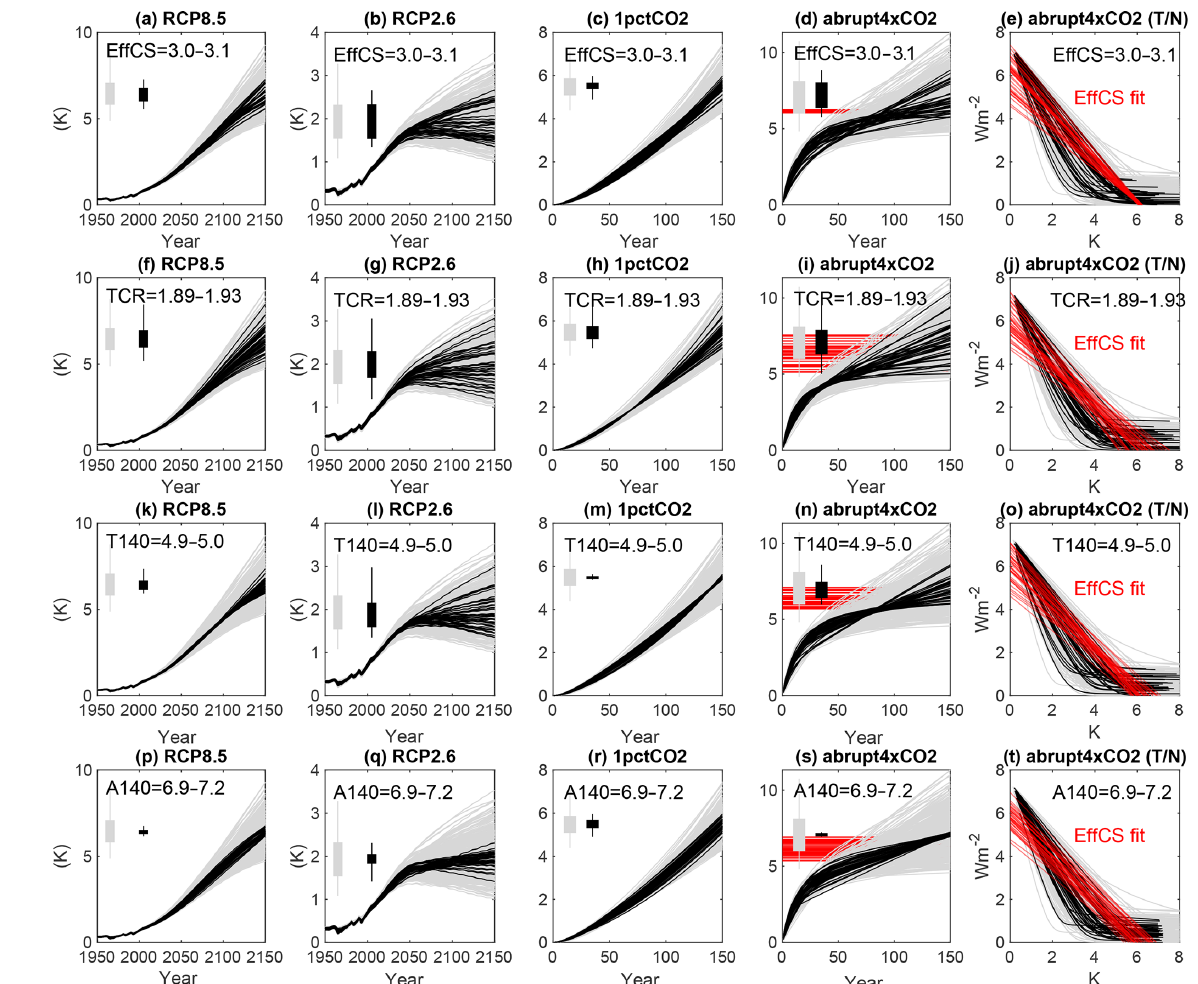
Figure 2. An illustration of how constraining different types of global sensitivity metric impact the idealized spread of global mean tem- perature evolution under different scenarios. Each row illustrates one constraint: effective climate sensitivity to CO 2 doubling (EffCS), TCR (70 years, CO 2 doubling), T140 (140 years, CO 2 quadrupling) and A140. Lines in grey show the entire posterior distribution of models from Fig. 1, while lines in black show the 45th–55th percentiles of the distribution of the respective quantity. Panels (a–s) show global mean tem- perature time series of a scenario or idealized experiment – RCP8.5, RCP2.6, 1% ramping CO 2 , abrupt CO2 quadrupling (the fifth column shows energetic imbalance as a function of surface temperature in the abrupt4xCO2 experiment). Histograms show the resulting distribution of temperature in 2150 (RCP8.5/2.6) or year 140 (1pctCO2, abrupt4xCO2) for the complete distribution (grey) and 45th–55th percentile range (black). Red lines show the distribution of values of effective climate sensitivity (d, i, n, s) and the trend lines used to compute it (e, j, o, t)